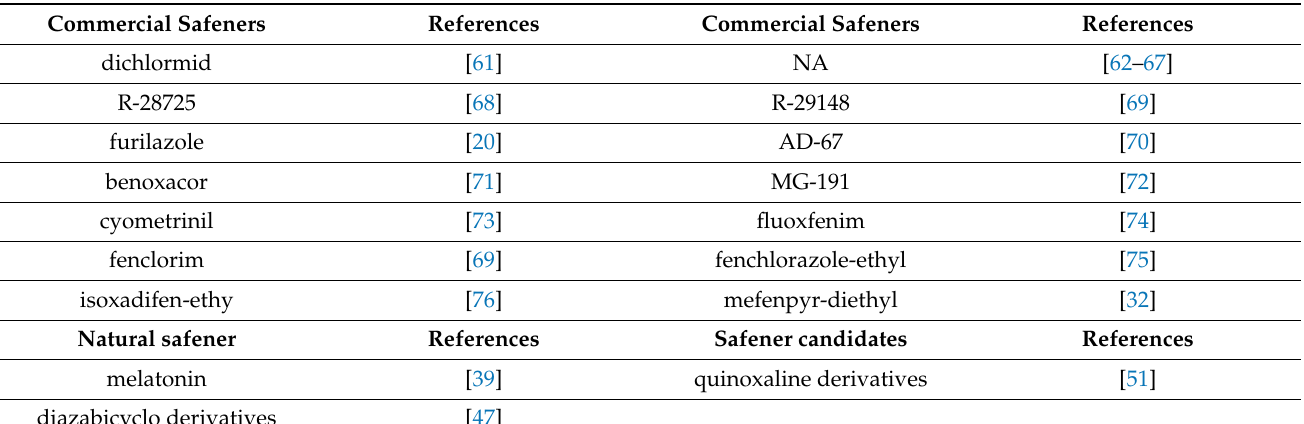
Table 2. Recent commercial safeners and some safener candidates induced enhancement of P450